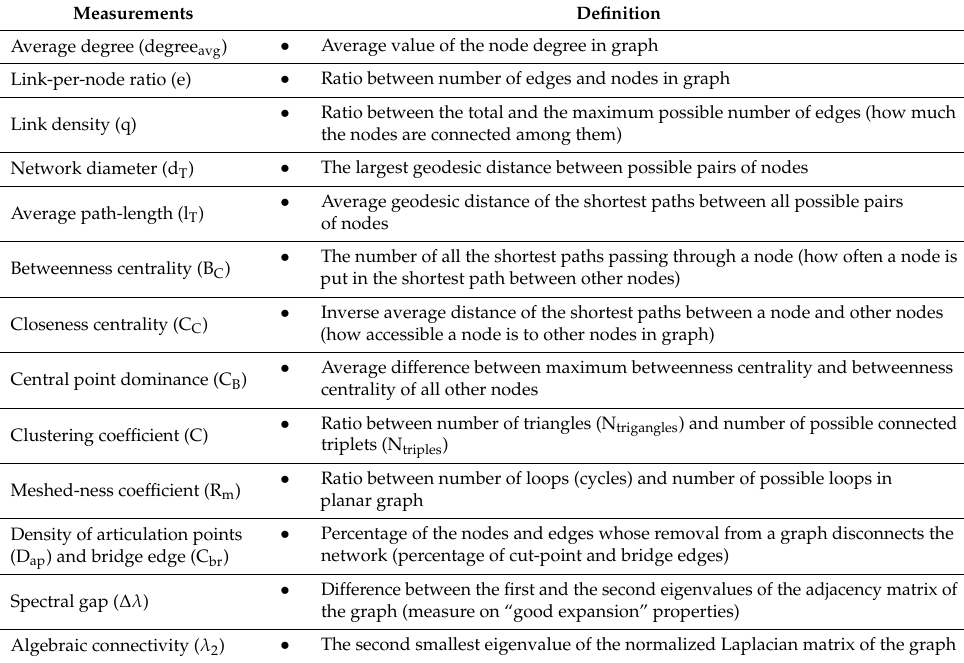
Table 4. Structural network measurements commonly used for resilience measure (Adapted from